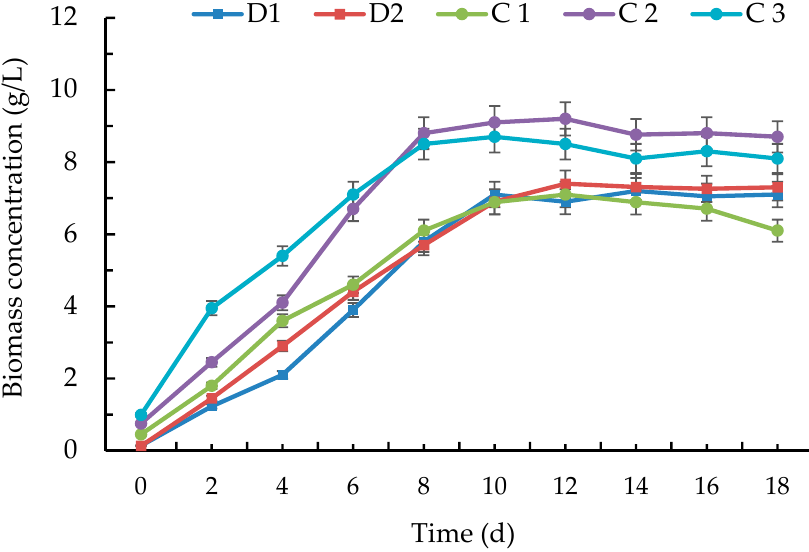
Figure 3. Biomass production during the five treatments (see Tables 2 and 3).